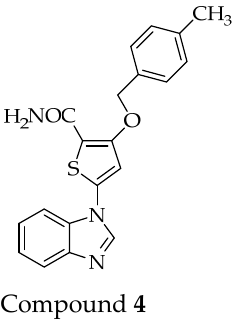
Figure 26. SARs of benzimidazole substituted with thiophene.